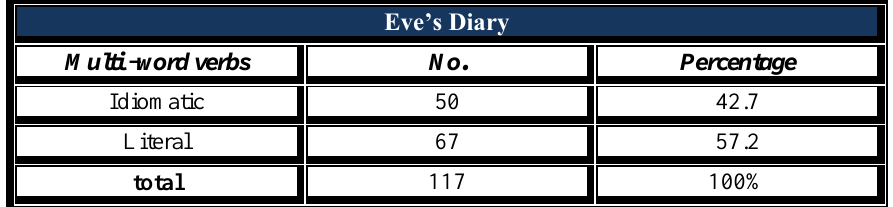
Table 7 – The percentage of idiomatic and literal PVs in ED